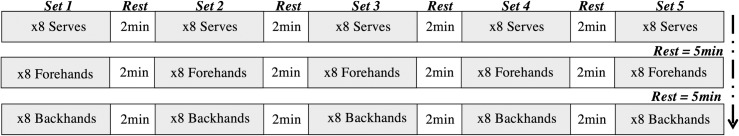
StV and accuracy experimental design.